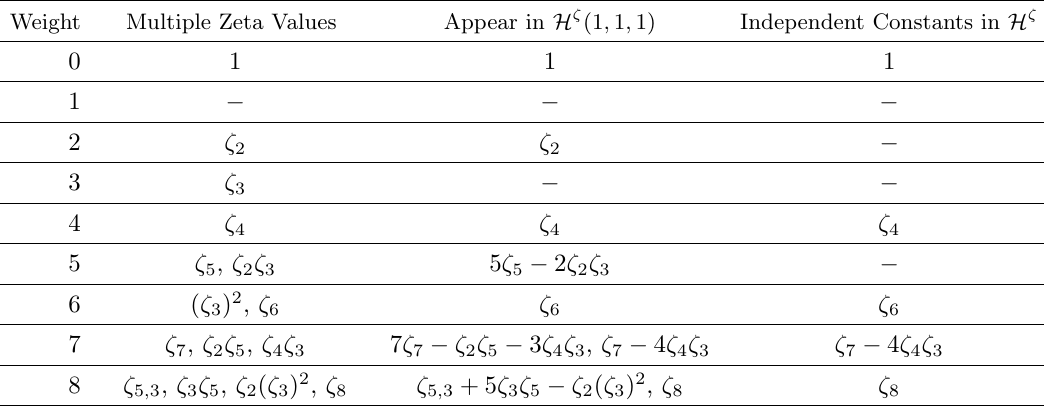
Table 2 . Through weight 8, we display (cid:12)rst the complete set of MZVs, followed by the linear combinations that appear in the intermediate function space H (cid:16) (cid:27) H hex when the functions are evaluated at (1 ; 1 ; 1), followed by the independent constants that are required in H (cid:16) .